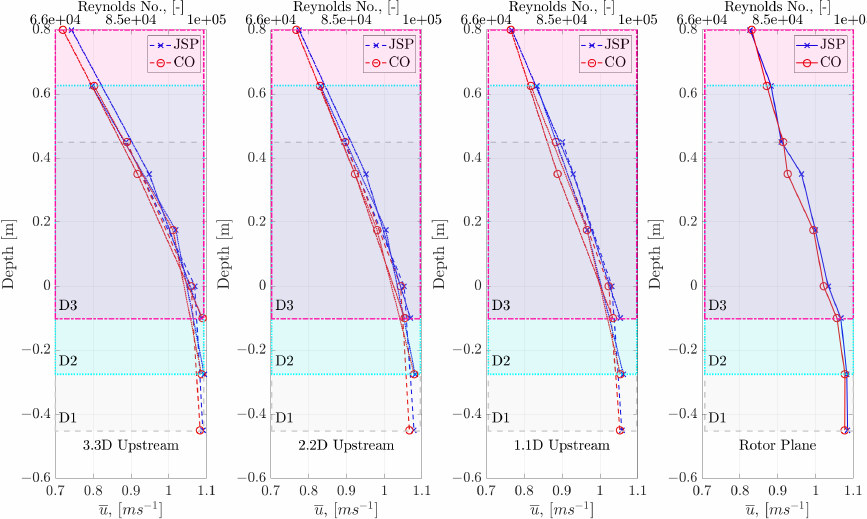
Figure 4. Mean stream-wise fluid velocity, u , against depth. Each chart presents the results for differing LDV positions; shaded regions highlight the turbine rotor span at each of the depths tested—D1, D2 and